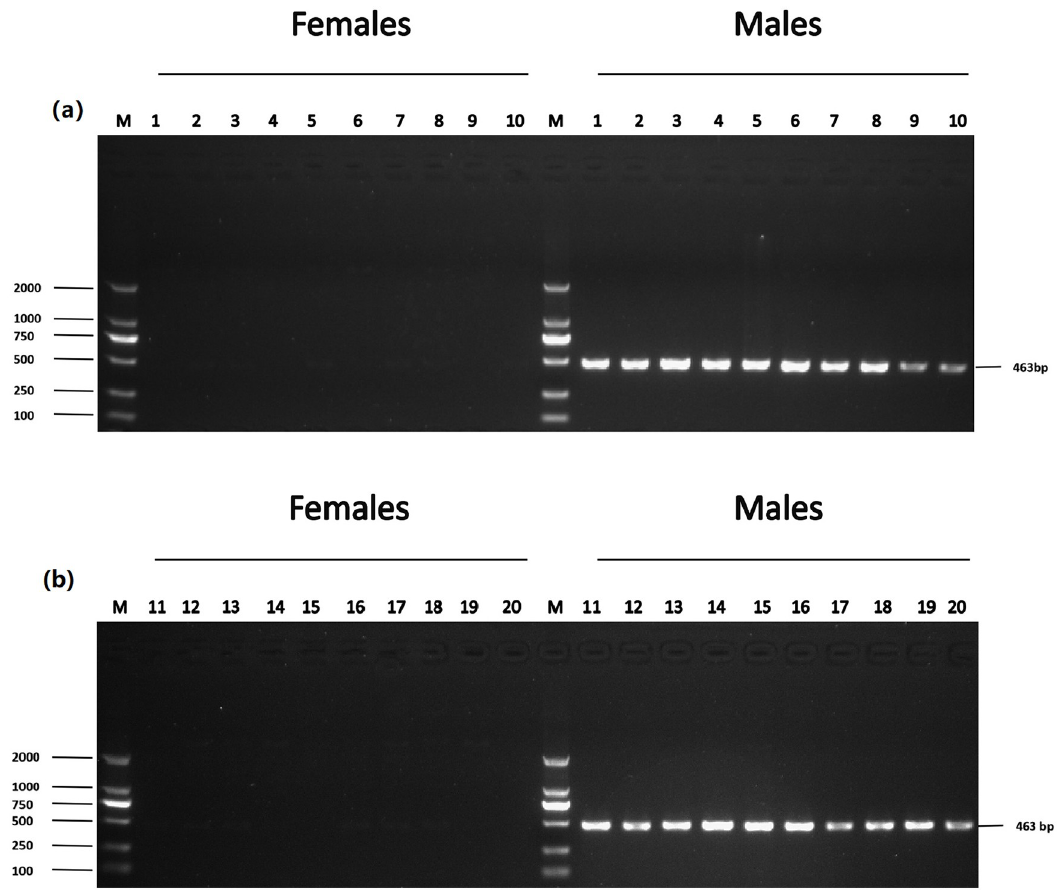
Fig 4. Identification of a male-specific tag, DNA fragment, amplified with Tag8743751. The left shows DL 2000 DNA marker sizes; the right shows fragment sizes.